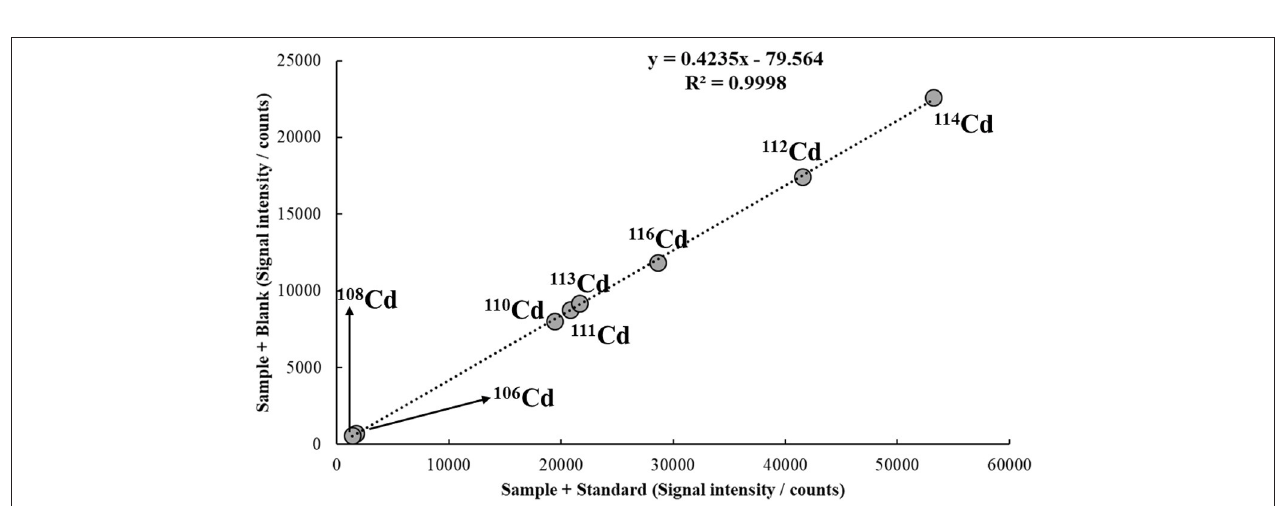
FIGURE 7 | MICal plot used to determine Cd in a tap water sample spiked with 10 µ g/L of the analyte. S1 and S2 were prepared with 70% of sample and 30% of standard solution or blank. The concentration of Cd standard added to S1 [ C(A) Std ] was 30 µ g/L. He flowing at 3.5 mL/min was used in the collision/reaction cell.